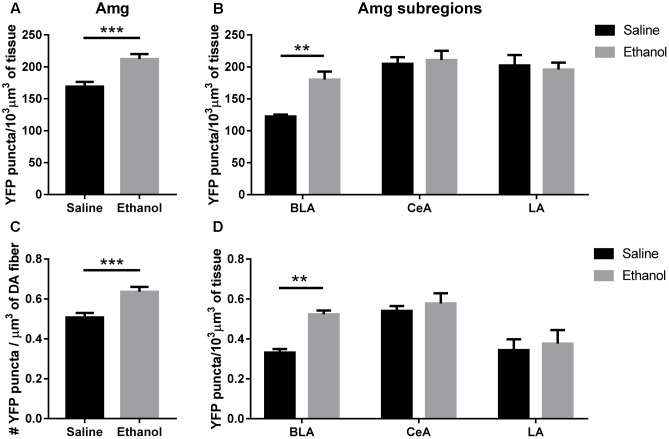
Acute ethanol exposure significantly increases levels of α4 subunit in the basolateral amygdala but not the central or lateral amygdala. (A,B) Effect of acute ethanol on the volumetric density of YFP puncta in the amygdala (A), or the BLA, CeA and LA (B) subregions. Data are presented as mean puncta density per 103 μm3 of tissue ± SEM. (A: two-tailed unpaired t-test, ∗∗∗p < 0.001, compared to saline; B: Two-way ANOVA, followed by Sidak post hoc analysis, ∗∗p < 0.01, compared to saline). (C,D) Effect of acute ethanol on the volumetric density of YFP puncta within TH immunoreactive fibres in the amygdala (C), or the BLA, CeA and LA (D) subregions. Data are expressed as mean puncta density per μm3 of TH immunoreactive fibres ± SEM. (C: two-tailed unpaired t-test, ∗∗∗p < 0.001, compared to saline; D: Two-way ANOVA, followed by Sidak post hoc analysis, ∗∗p < 0.01, compared to saline).